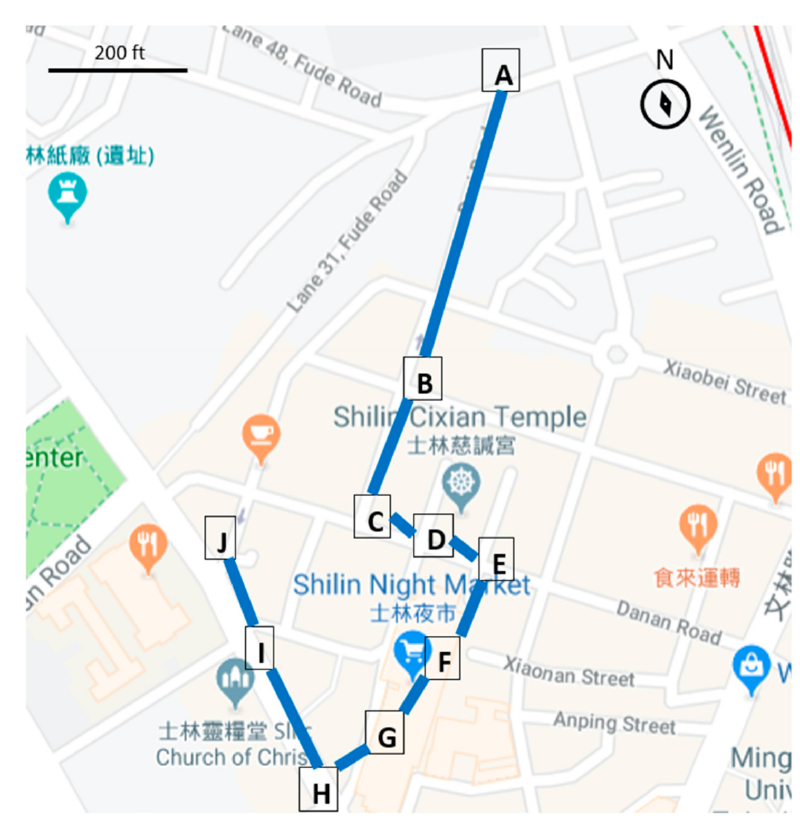
Figure 3. PM 2.5 concentrations during a walk across a business district that includes a night market and a temple on 27 April 2019.